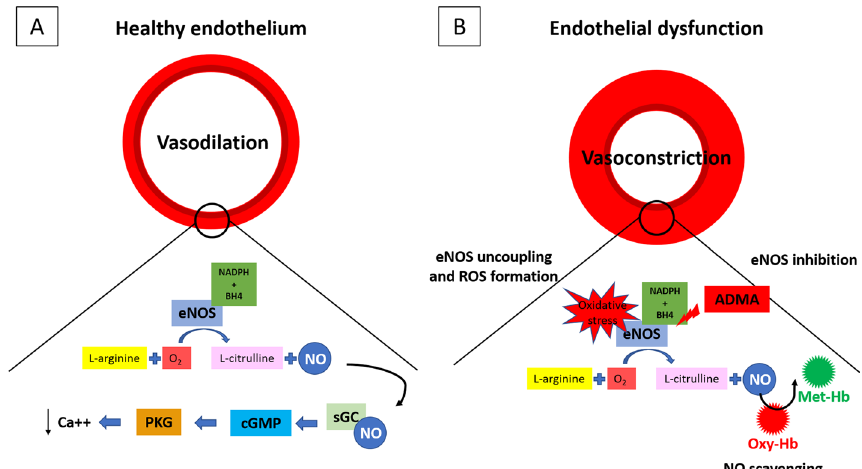
Fig. 1 NO biosynthesis and eNOS uncoupling. Endogenous NO is produced by NOS by the oxidation of l -arginine to l -citrulline + NO (NADPH and BH4-dependent reaction). NO is one of the end-products of the reaction. Most of the effects of NO in the cardiovascular system are mediated by the activation of sGC, which catalyzes the formation of the second messenger cGMP from GTP. The activation of GMP ‐ dependent PKG leads to vascular relaxation ( A ). Several circumstances may alter eNOS activity causing the reduction of NO levels and triggering the production of superoxide instead of NO, a process defined as “eNOS uncoupling”. For example, the depletion of eNOS cofactor BH4, l -arginine deficiency, and increase in endogenous eNOS inhibitor ADMA lead to eNOS uncoupling. This process is largely deleterious and has been linked to endothelial dysfunction, ROS increase and other vascular pathologies. Moreover, NO bioavailability is reduced by free oxy-Hb. B NO: nitric oxide; NOS: nitric oxide synthase; sGC: soluble guanylate cyclase; cGMP: cyclic guanosine monophosphate; GTP: guanosine-5 ′ -triphosphate; PKG: Protein Kinase G; BH4: tetrahydrobiopterin; ADMA: asymmetric dimethylarginine; oxy-Hb: